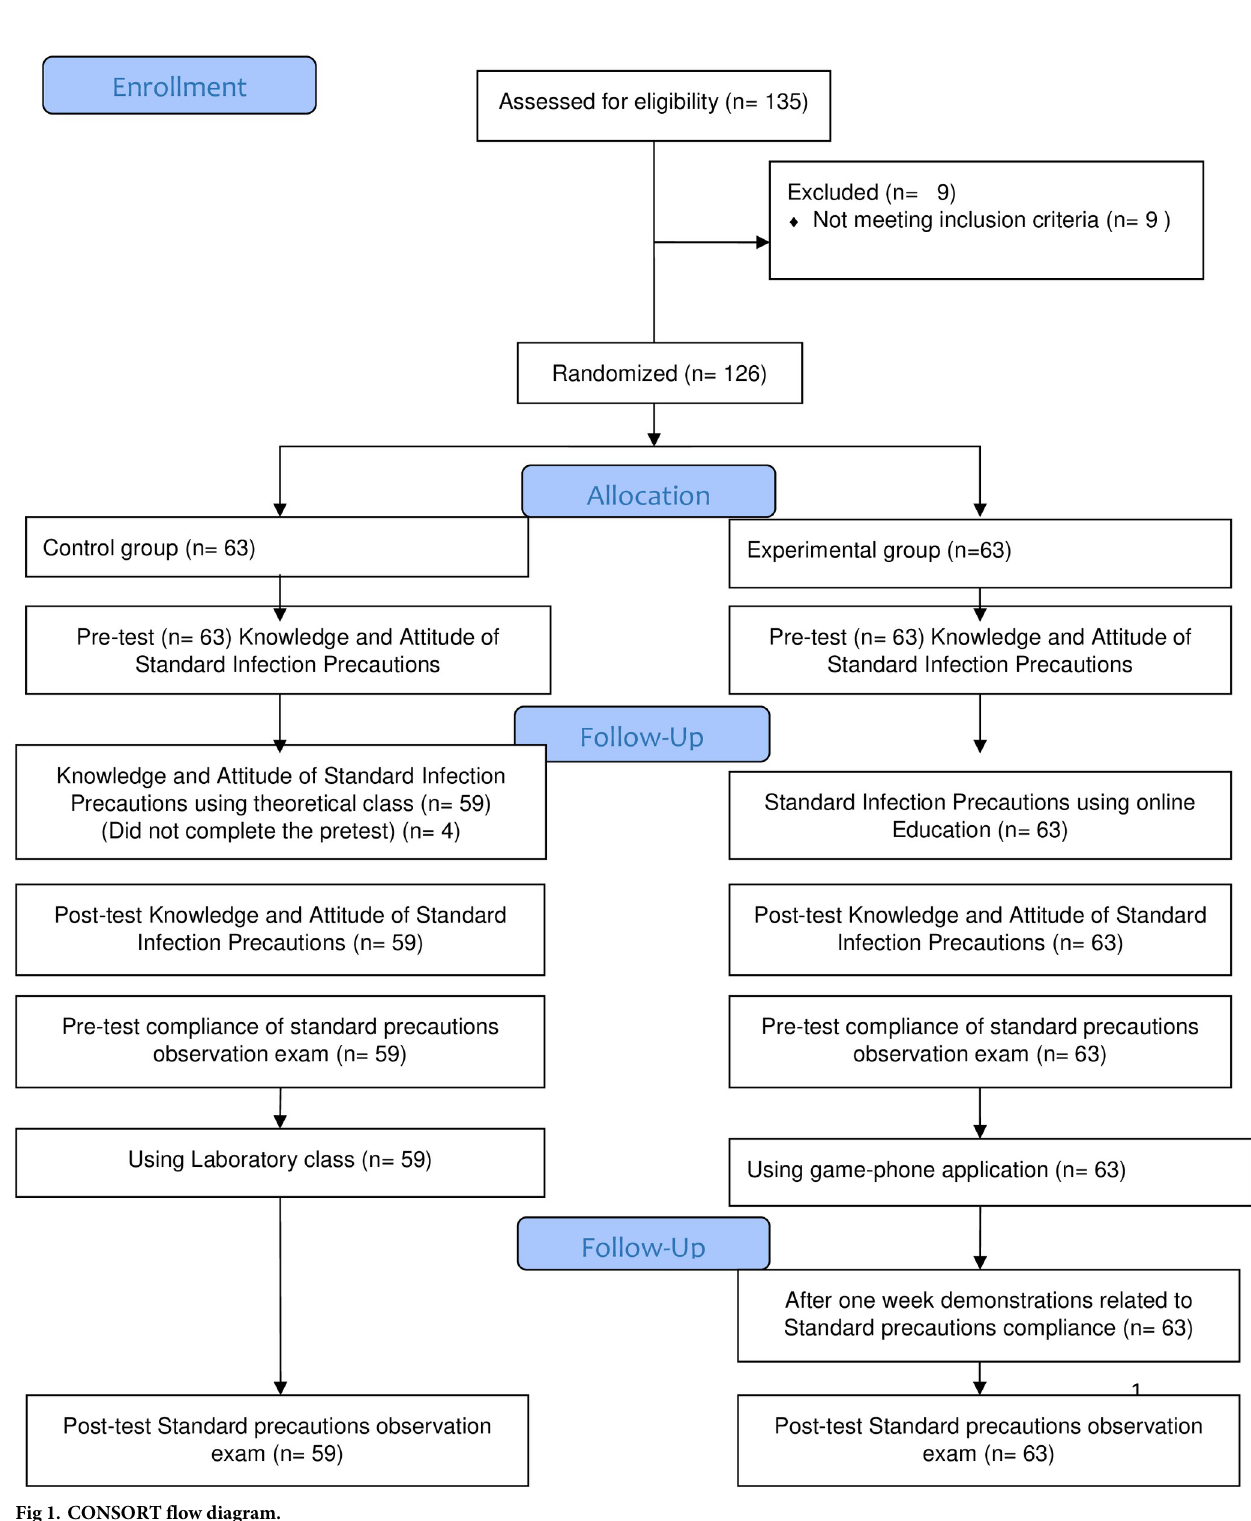
PLOS ONE | https://doi.org/10.1371/journal.pone.0275130 November3,